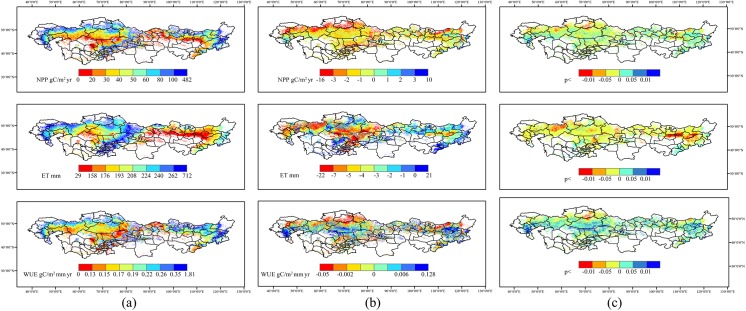
Regional spatial distributions of (a) mean annual value, (b) annual change value and (c) temporal significance of NPP, ET and WUE in Temperate Eurasian Steppe from 1999 to 2008.